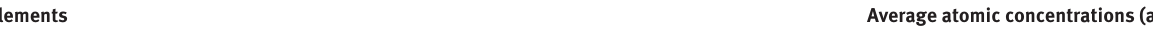
Table 1: Atomic concentrations (at.%) of O, Si, and C elements for the a-SiC samples that have been anodically etched for 30 min in 0.5% HF/EG solution and for 50 min in 0.5% HF/H O solution with a current density of 0.5, 1.0, 2.0, and 2.5 mA/cm 2 , respectively. 2 Elements Average atomic concentrations (at.%) Control sample